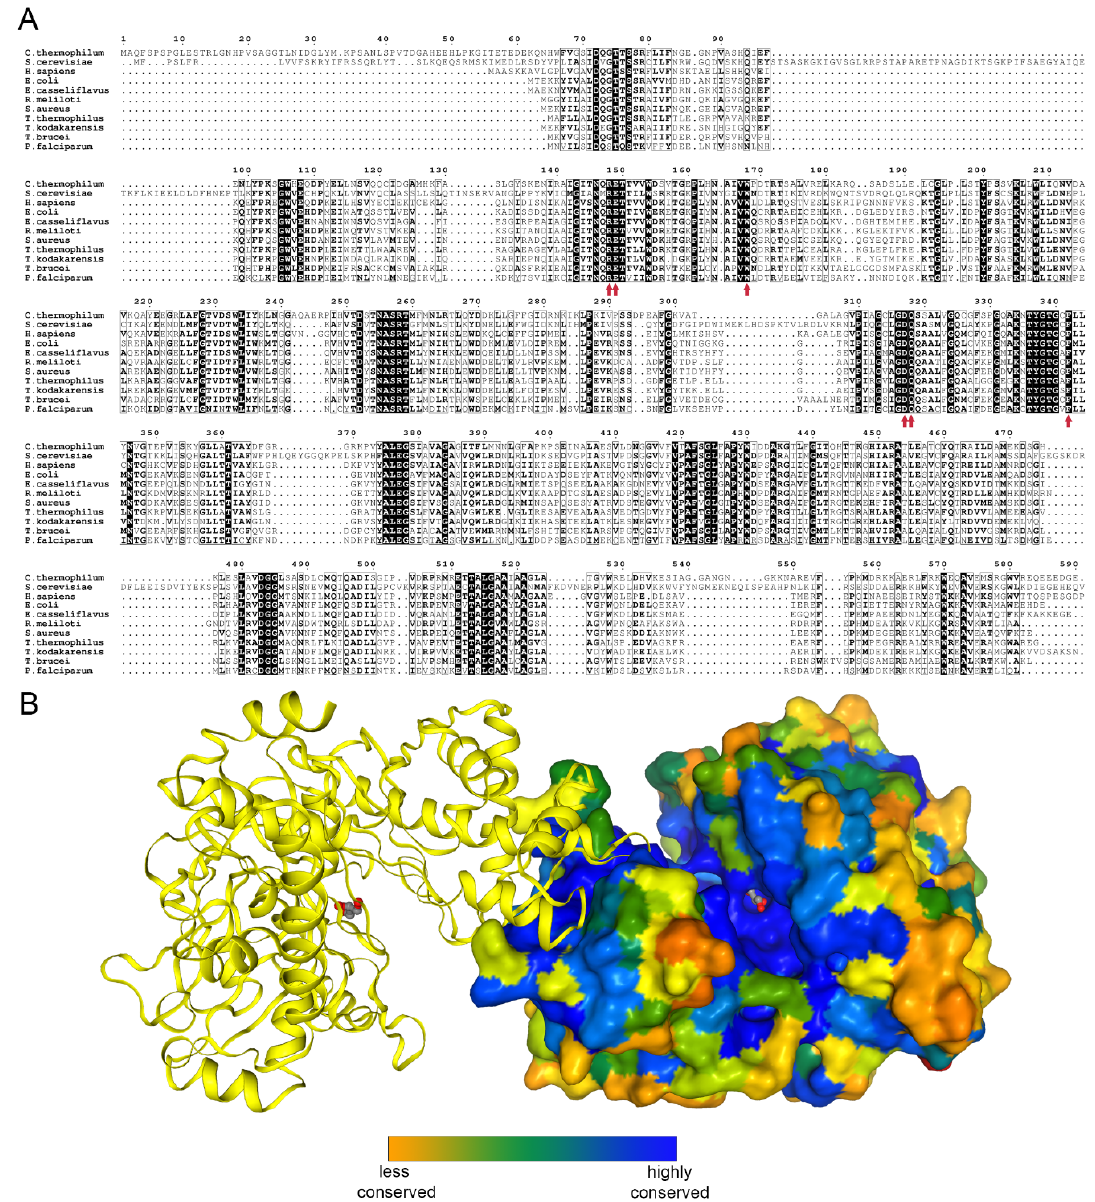
Figure 1. Glycerol kinase conservation. ( A ) Sequence alignment of human, Saccharomyces cerevisiae , and all to-date crystalized glycerol kinases prepared using the ENDscript server [6]. The glycerol binding residues are indicated by red arrows. ( B ) A biological dimer of Chaetomium thermophilum glycerol kinase (CtGK); one subunit is shown as surface and colored by sequence conservation as analyzed by EPPIC [7].